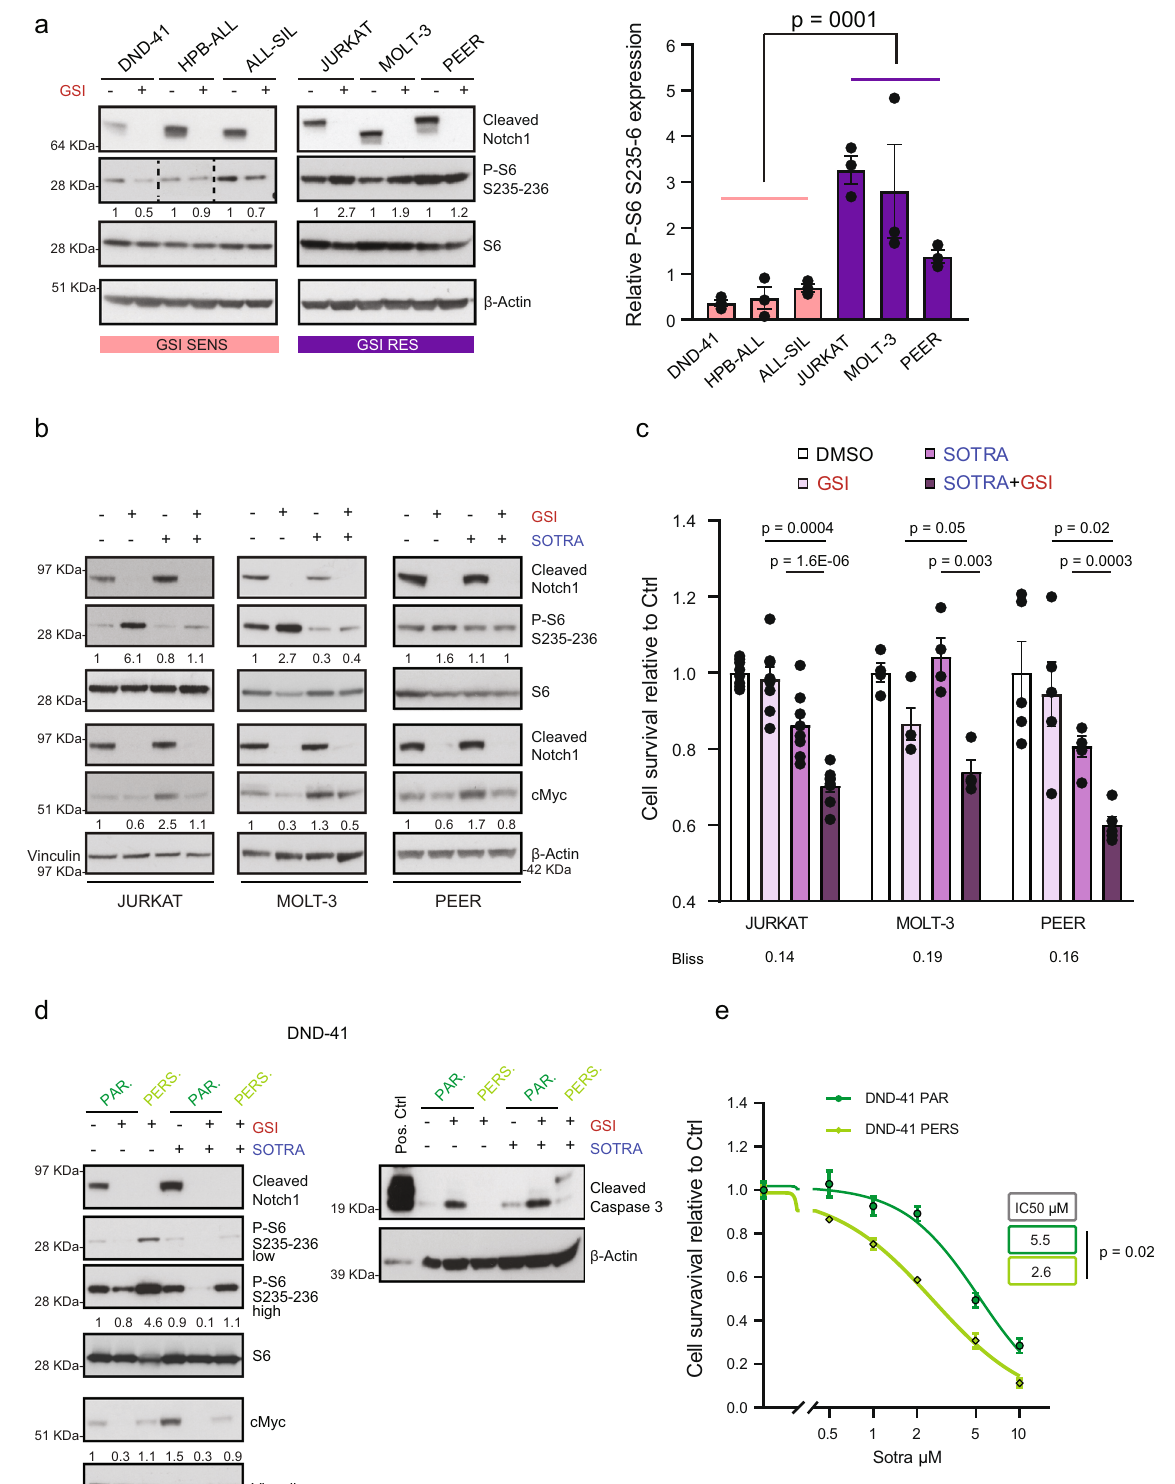
according to the guidelines of the local ethics committee. For initial xenografts establishment, 6 – 9 weeks-old NOD/SCID mice (NOD.CB17-Prkdcscid/NCrCrl), purchased from Charles River Laboratories, were injected intravenously (i.v.) with 1 ×10 7 T-ALL cells in 300 ml of Dulbecco ’ s phosphate-buffered saline. Secondary transplants were obtained by injecting 5× 10 6 T-ALL cells per mouse 18 . Resistance to NOTCHi was developed as previously described 19 . 5 ×10 6 cells of PDTALL11 and PDTALL19 cells were i.v. injected in NOD/SCID